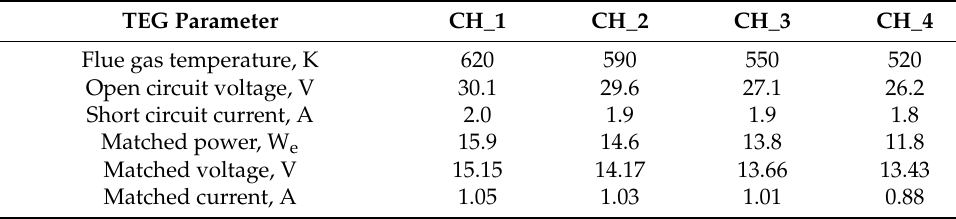
Figure 11. I–V and P–V characteristics of the tested thermoelectric generator. Table 1. The essential parameters of TEG depending on the flue gas temperature. TEG Parameter